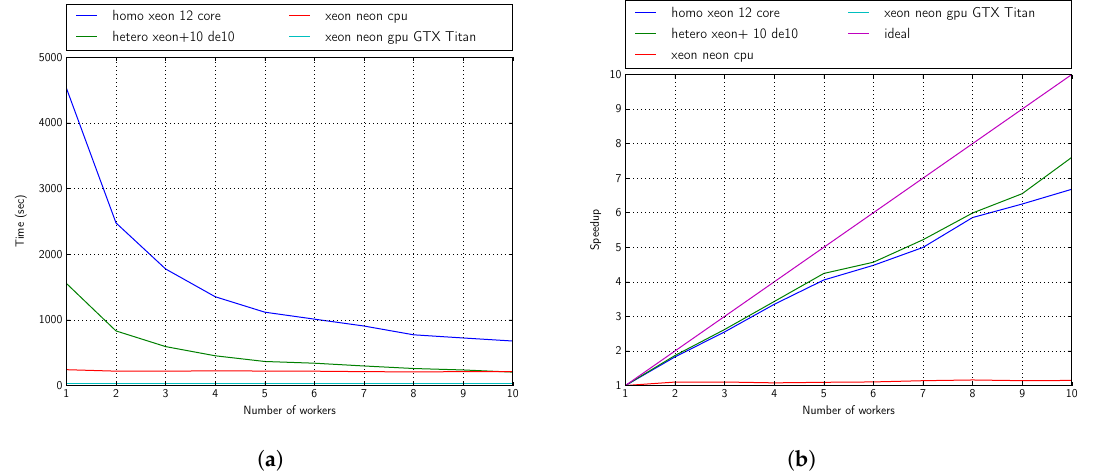
Figure 12. Performance: 3 generations, 16 individuals, Xeon platform. ( a ) Time; ( b ) Speedup.